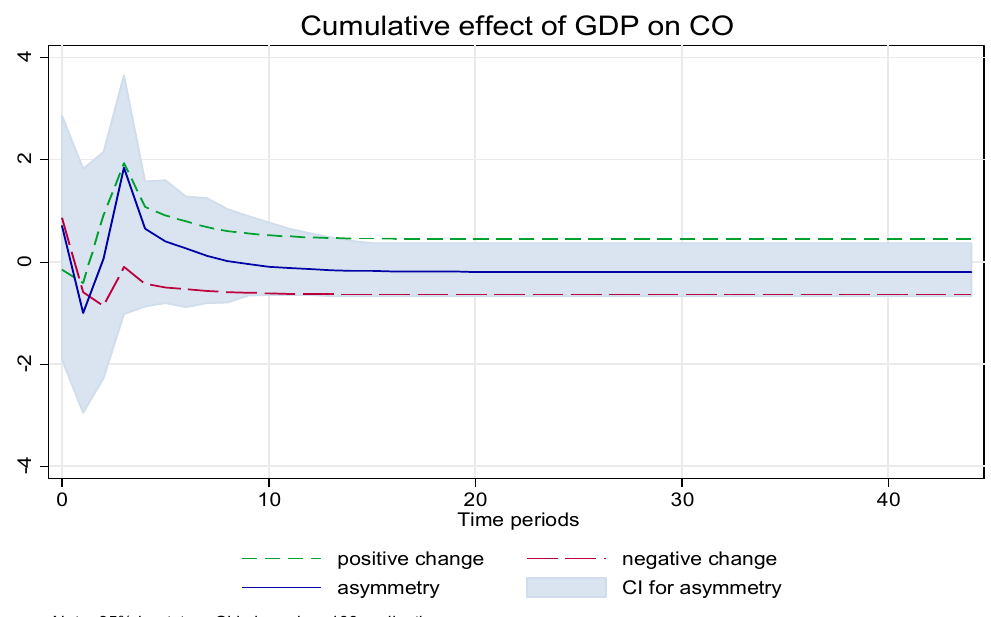
Figure A1. Cumulative effect of GDP on CO .